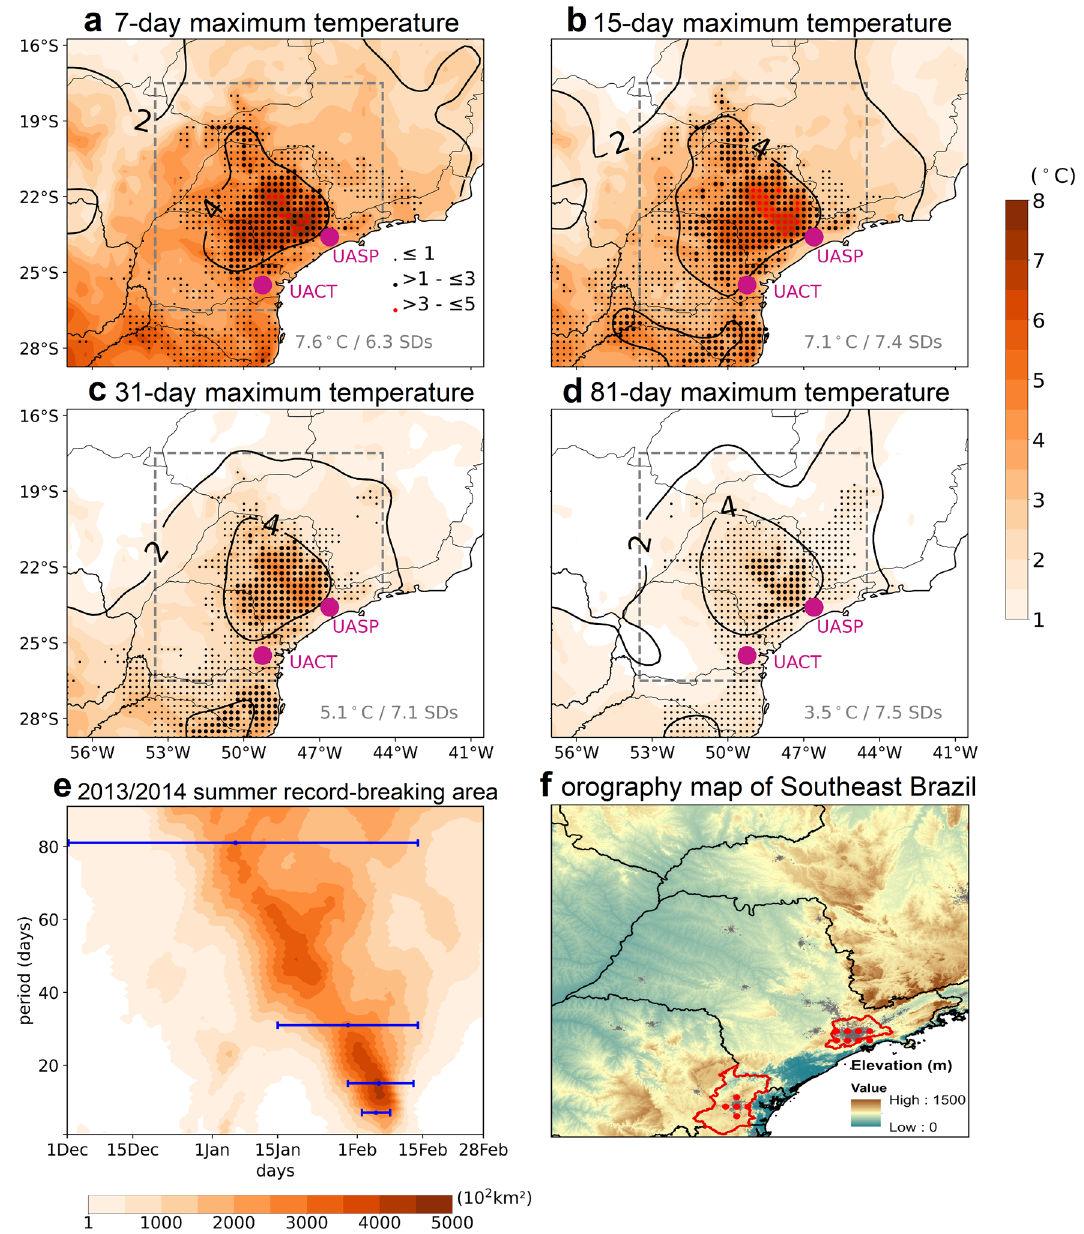
Figure 1. Spatio-temporal characterization of the record-breaking 2013/2014 summer. Maximum surface temperature anomalies (°C, relative to 1981–2010) during the 2013/2014 summer for 7-day ( a ), 15-day ( b ), 31-day ( c ) and 81-day average periods ( d ). Contour lines depict the anomaly divided by the corresponding standard deviation of all summer days of the reference period. The dots highlight record-breaking temperature anomalies with the size and the color being proportional to the exceedance over the previous period. The magenta dots indicate the location of the UASP and UACT. The maximum temperature anomaly is shown in the bottom right corner. Temporal evolution of the spatial extent (in 10 2 km 2 ) of areas experiencing record-breaking temperatures at different time scales during the 2013/2014 summer ( e ). Only the grid points within the grey box shown in the previous panels are considered. Blue bars indicate the period of maximum extension for the time scales represented in the previous panels. Orography map of the region within the grey box ( f ). The limits of the UASP and the UACT are shown by the red polygons. The grey shade highlights the urbanized areas and the red dots indicate the ERA5 and GLEAM grid-points considered to compute area averages for these particular urban